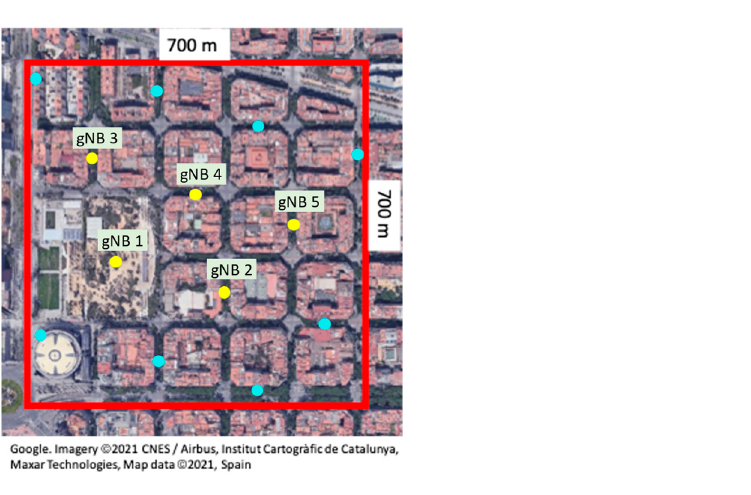
Figure 3. Map included in the scenario topology model of the implemented RAN NDT. The positions of the considered gNBs correspond to the yellow dots on the map. Table 1. Configuration of the implemented RAN NDT.